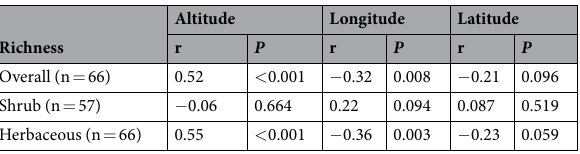
Table 2. The relationship between local species richness and geographic